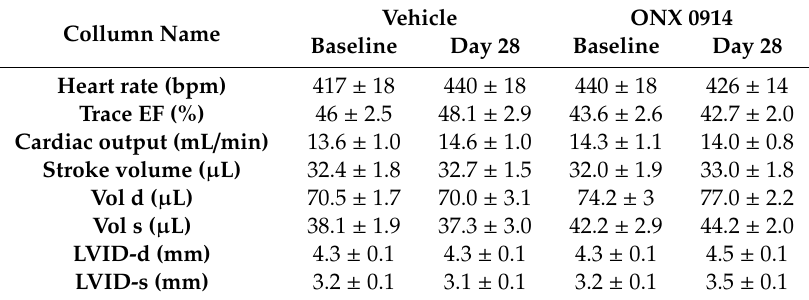
Table 1. Analysis of cardiac function in NMRI mice during chronic myocarditis.